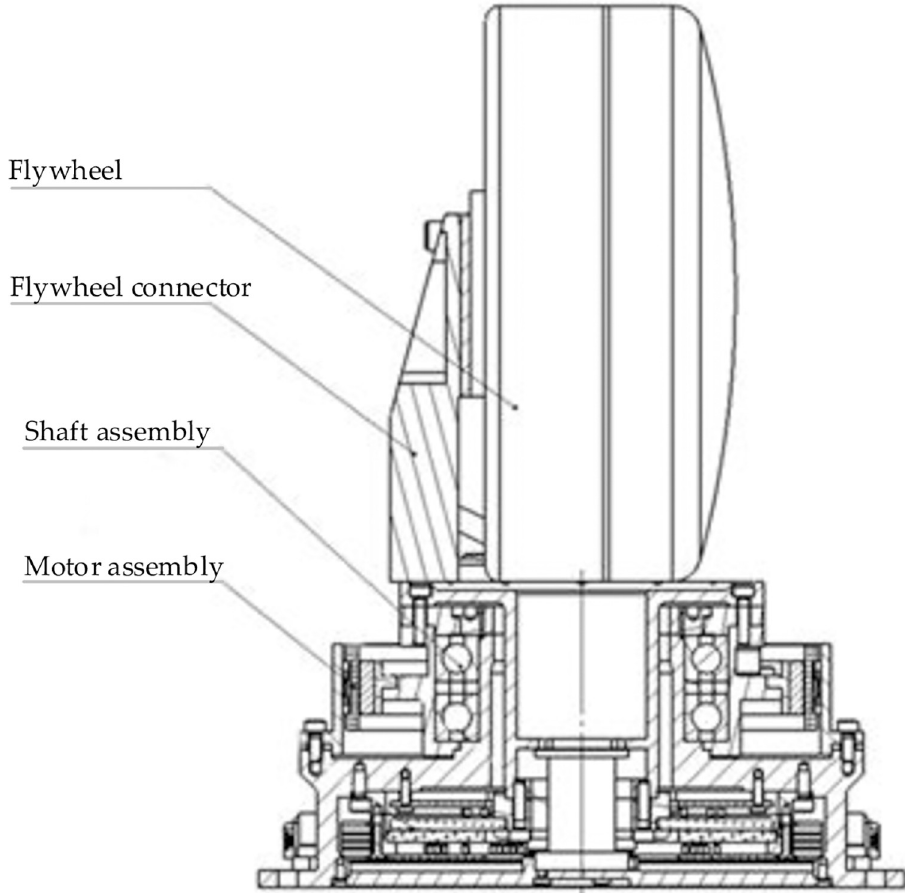
Fig 1. SGCMG system structure diagram.